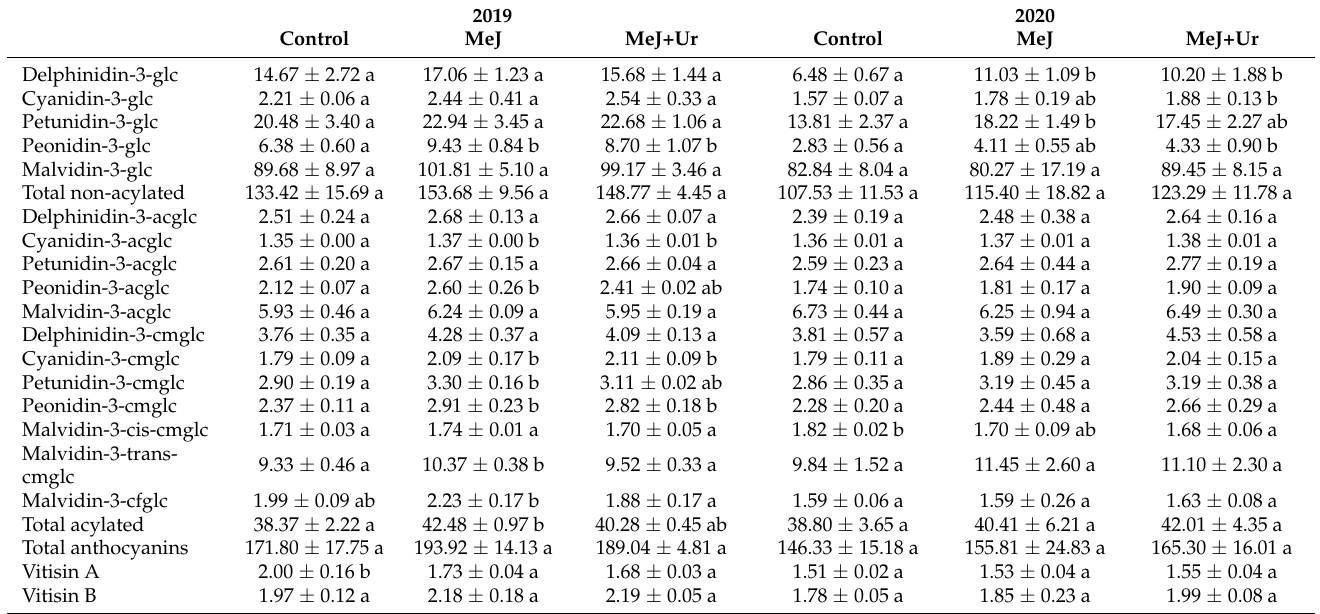
Nomenclature abbreviations: glc, glucoside; acglc, acetylglucoside; cmglc, trans-p-coumaroylglucoside; cfglc, caffeoylglucoside. All parameters are listed with their standard deviation ( n = 3). For each season and compound, different letters indicate significant differences between the samples ( p ≤